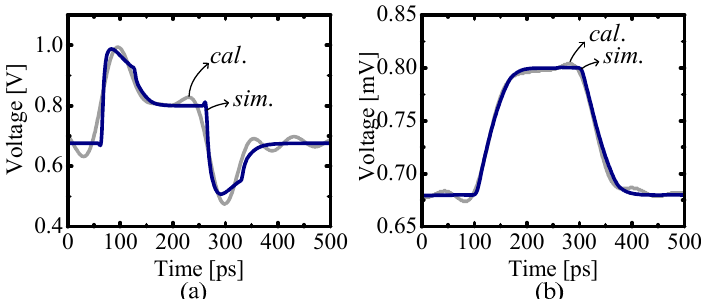
Figure 11. Comparison of pre-emphasis waveforms for the single-line system. ( a ) Input waveforms and ( b ) output waveforms. The gray lines (cal.) are waveforms determined by the proposed technique, and the blue solid lines (sim.) are simulation results obtained by circuit simulation.